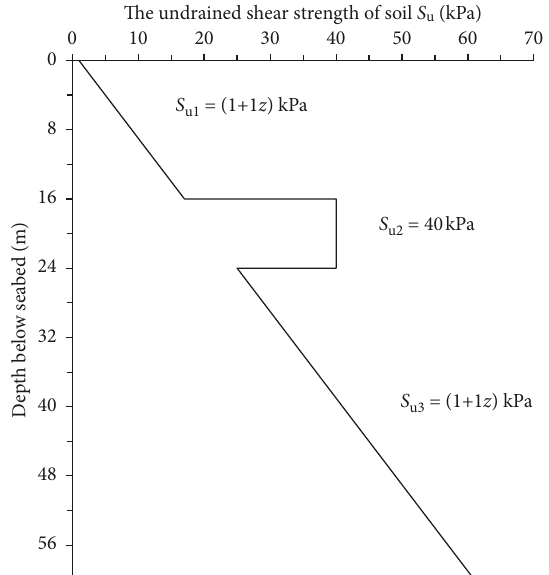
Figure 4: Typical seabed profiles with normally consolidated clay and an interbedded stiff